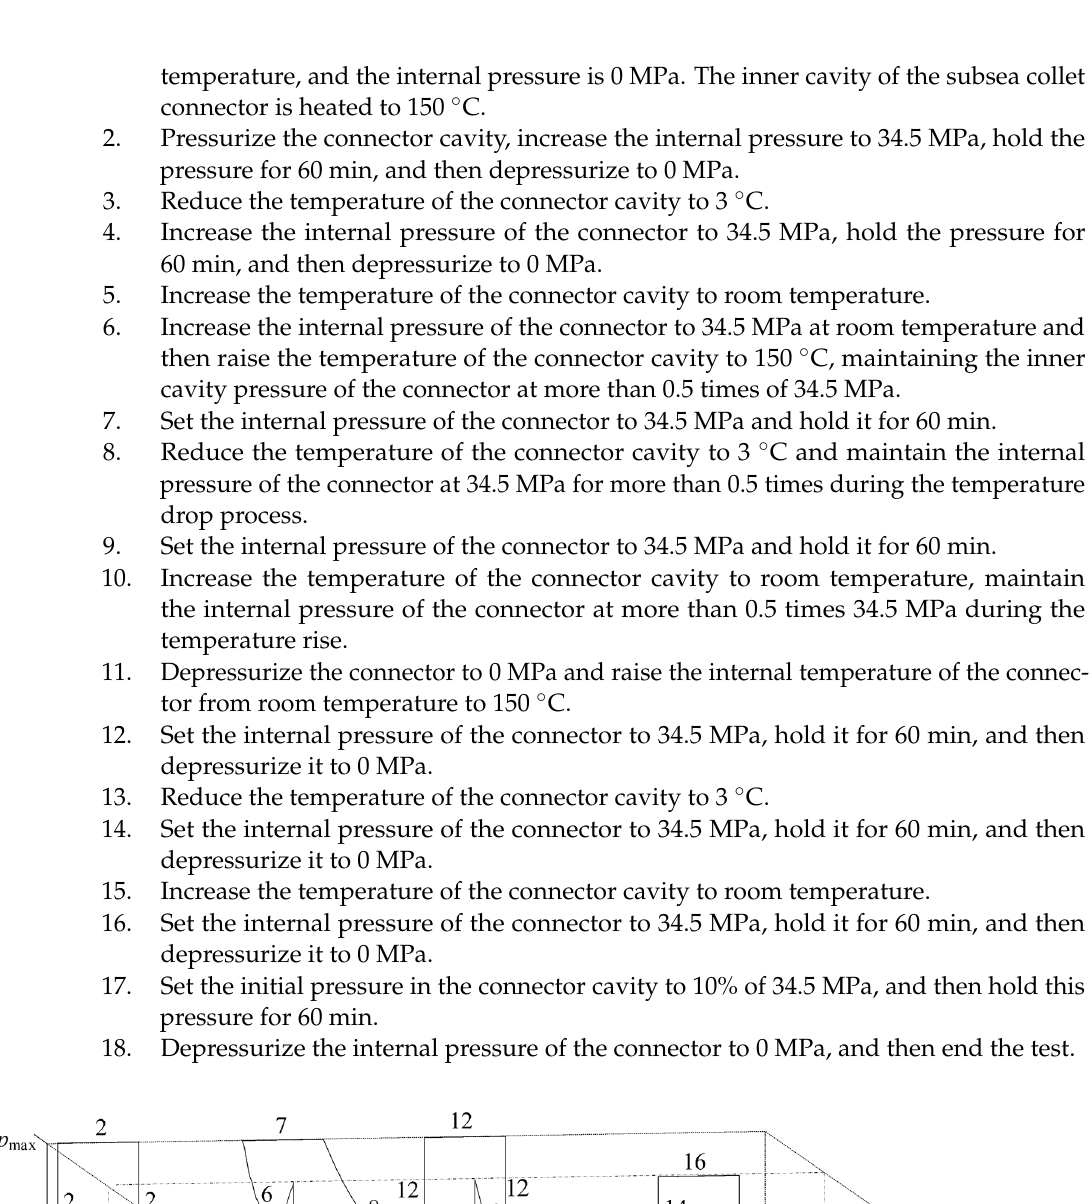
Figure 10. Schematic diagram of temperature cycle test.